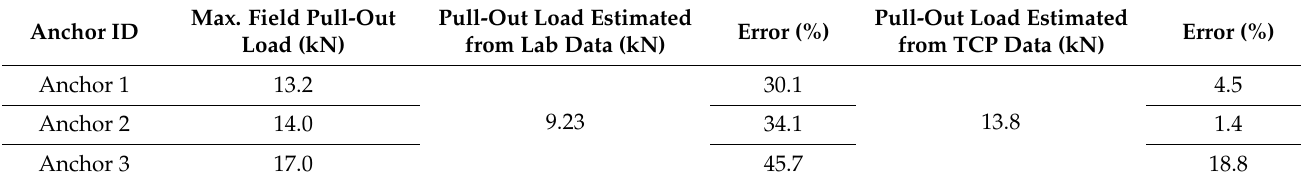
Table 3. Summary of maximum field pull-out load and pull-out capacity estimated from laboratory and TCP